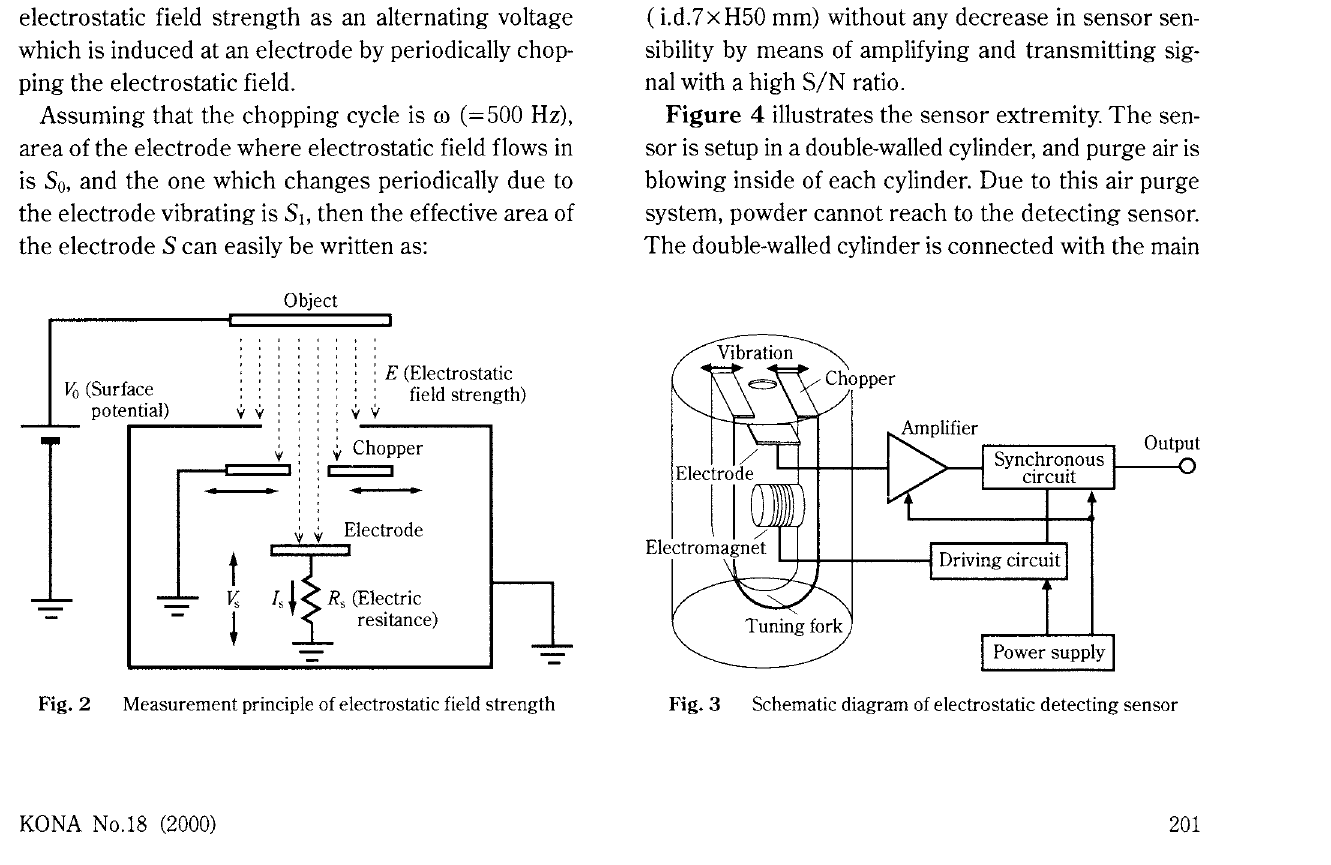
Fig. 2 Measurement principle of electrostatic field strength Schematic diagram of electrostatic detecting